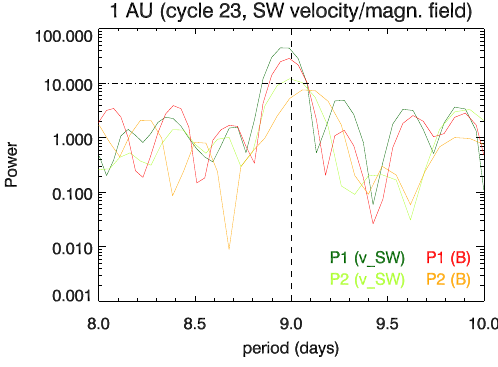
Fig. 11. Lomb periodograms the solar wind speed (green) and the magnetic field (red) in C23, detail of Fig. 10 around a periodicity of 9